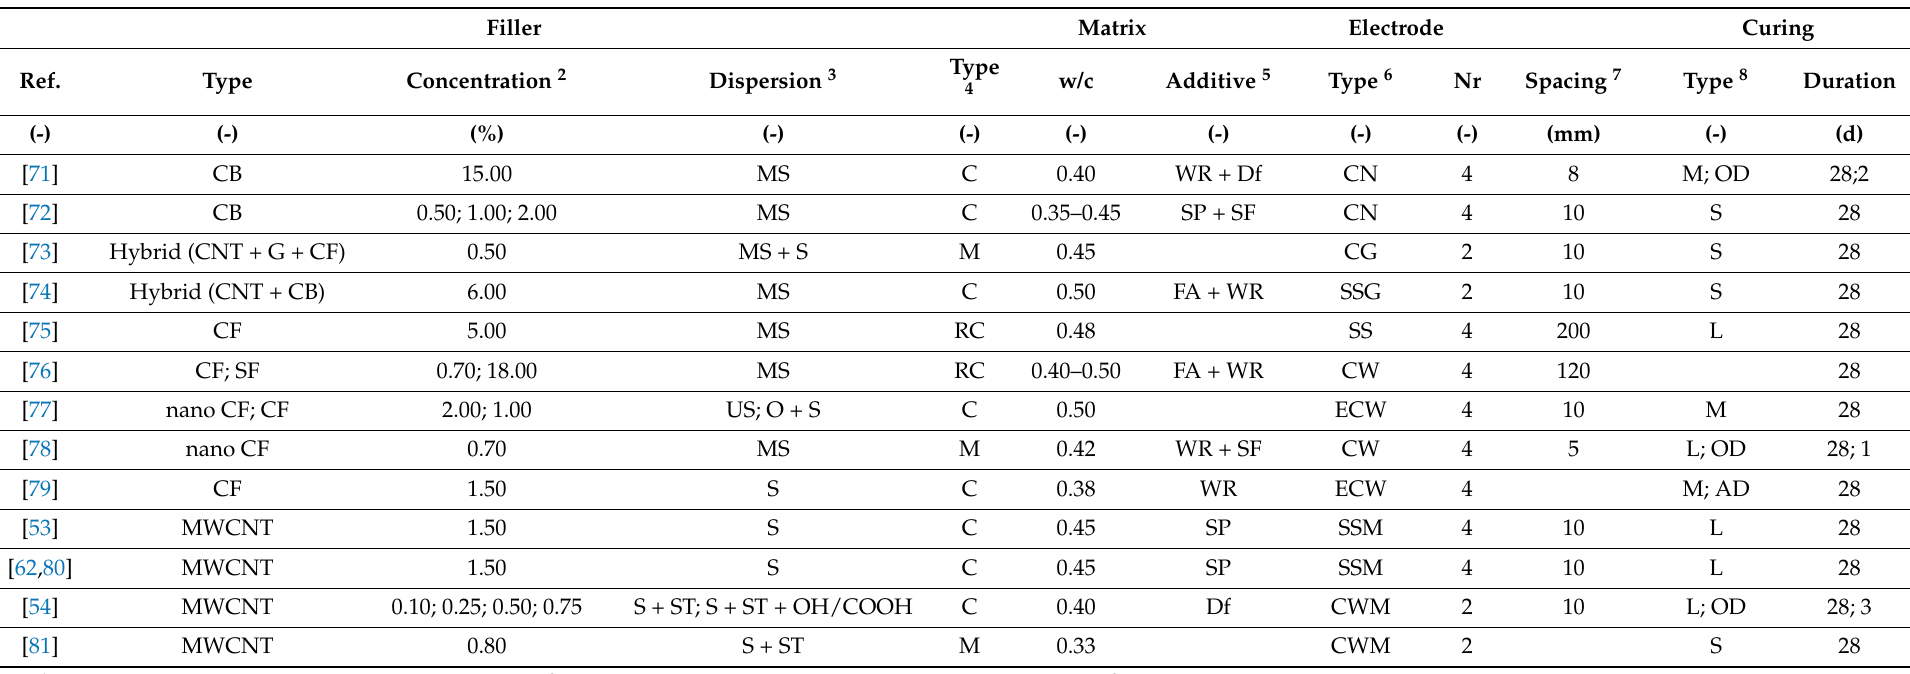
Table 1. Summary of fabrication parameters of CSCs applied for SHM of structural prototypes 1